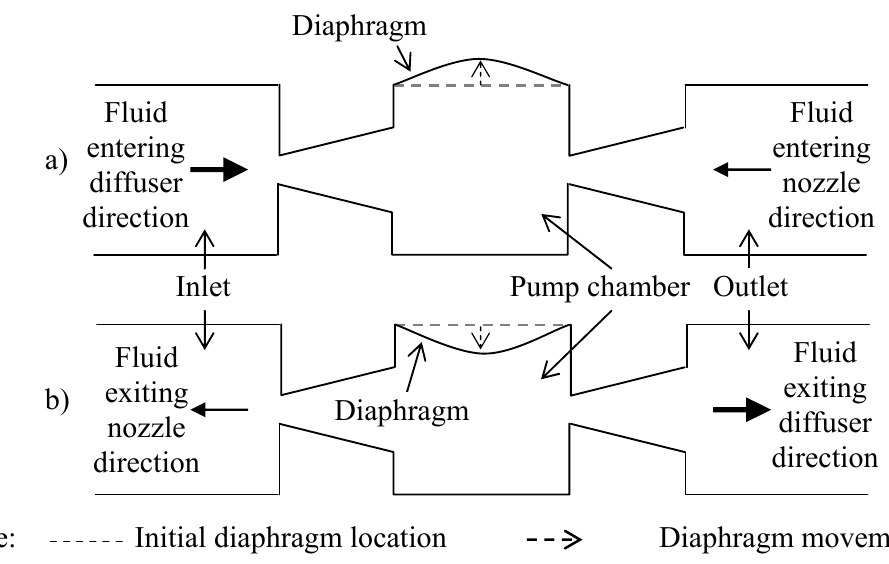
Figure 1. Working principle of a typical valveless micropump utilizing diffuser element during (a) suction mode (b) supply